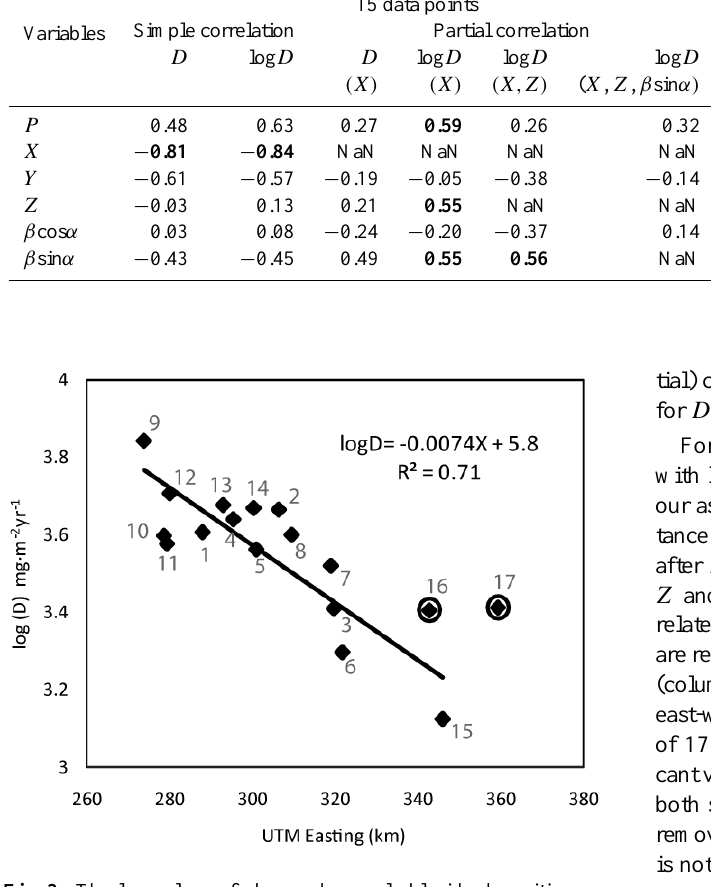
Fig. 3. The log values of observed annual chloride deposition vs. UTM Easting (as a proxy for coastal distance), with sites #16 and #17 excluded in the regression. The numbers next to the symbols correspond to those in Table 1 and Fig.